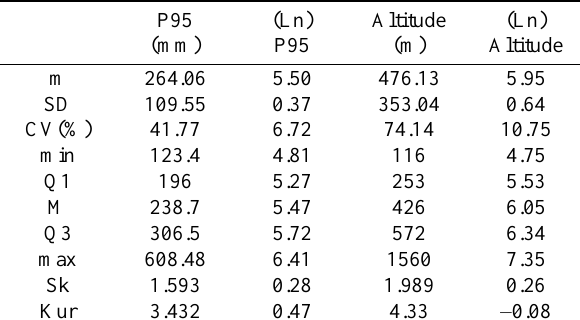
Table 1. Descriptive statistics for P95 and altitude respective